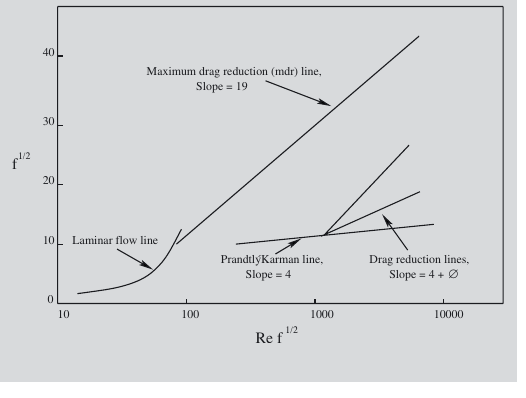
Figure 3: A schematic Prandtl-Kar- man plot depicting slope increment, D , following drag